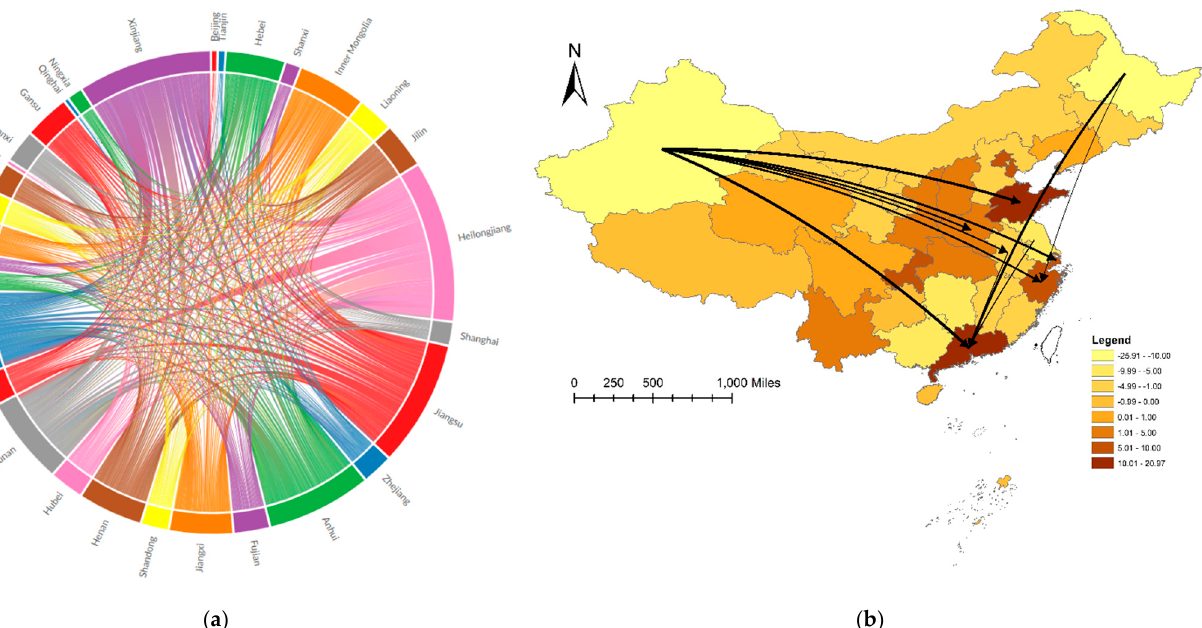
Figure 1. Water inflow ( a ), water outflow ( b ), and water net flow ( c ) of inter-provincial virtual water trade in each province. Note: We only show the top five sectors with the largest virtual water trade volume, and merge the remaining 36 sectors into “other”. In Figure 1c, negative numbers indicate net outflows, and positive numbers indicate net inflows.